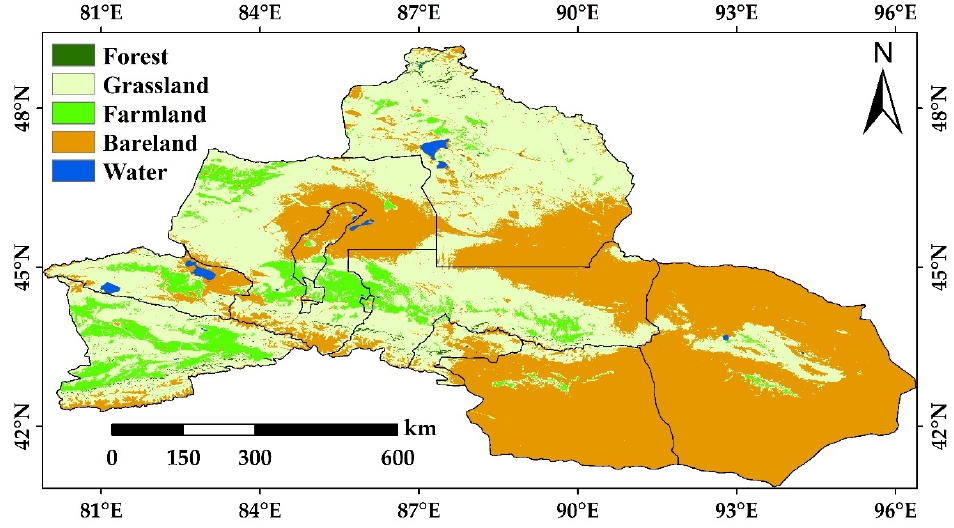
Figure 2. Land cover reclassification in NX (based on MCD12Q1 IGBP).